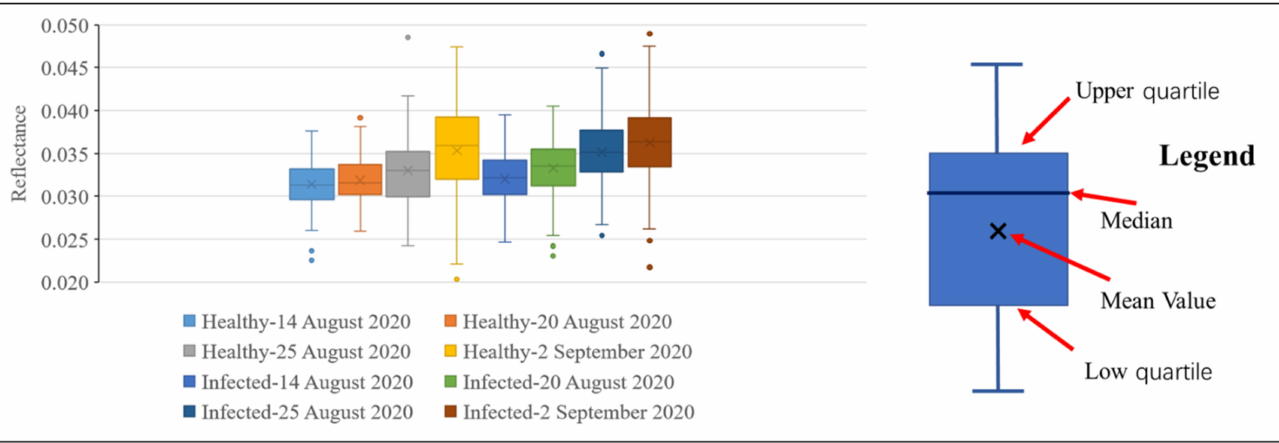
Figure 9. Box diagram of reflectance values of infected and healthy rice at 680 nm on different